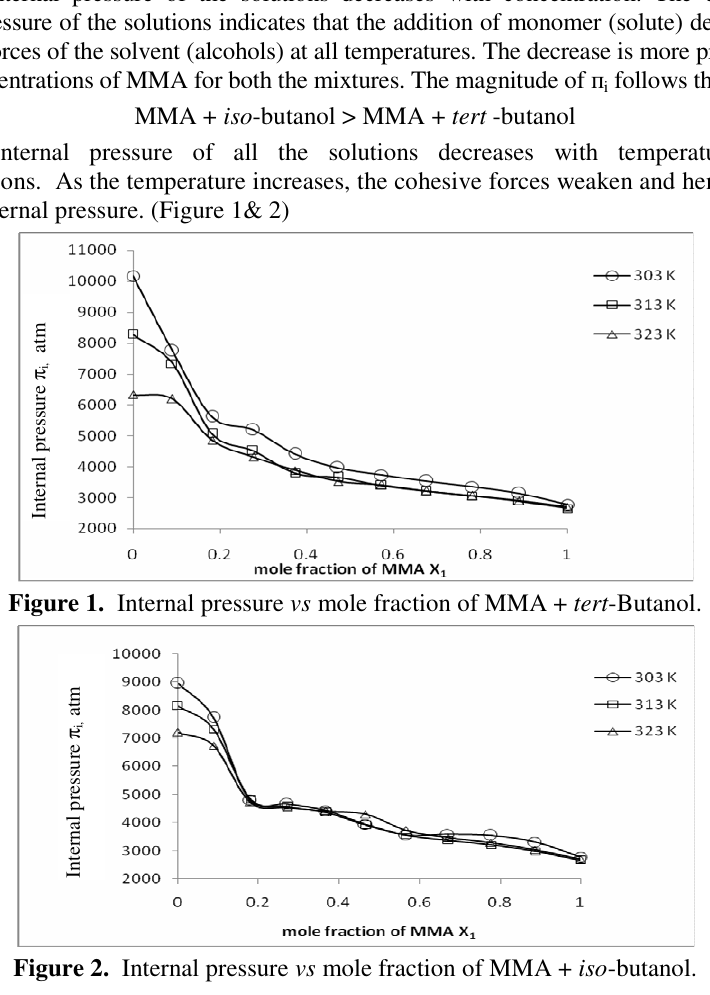
Figure 2. Internal pressure vs mole fraction of MMA + iso